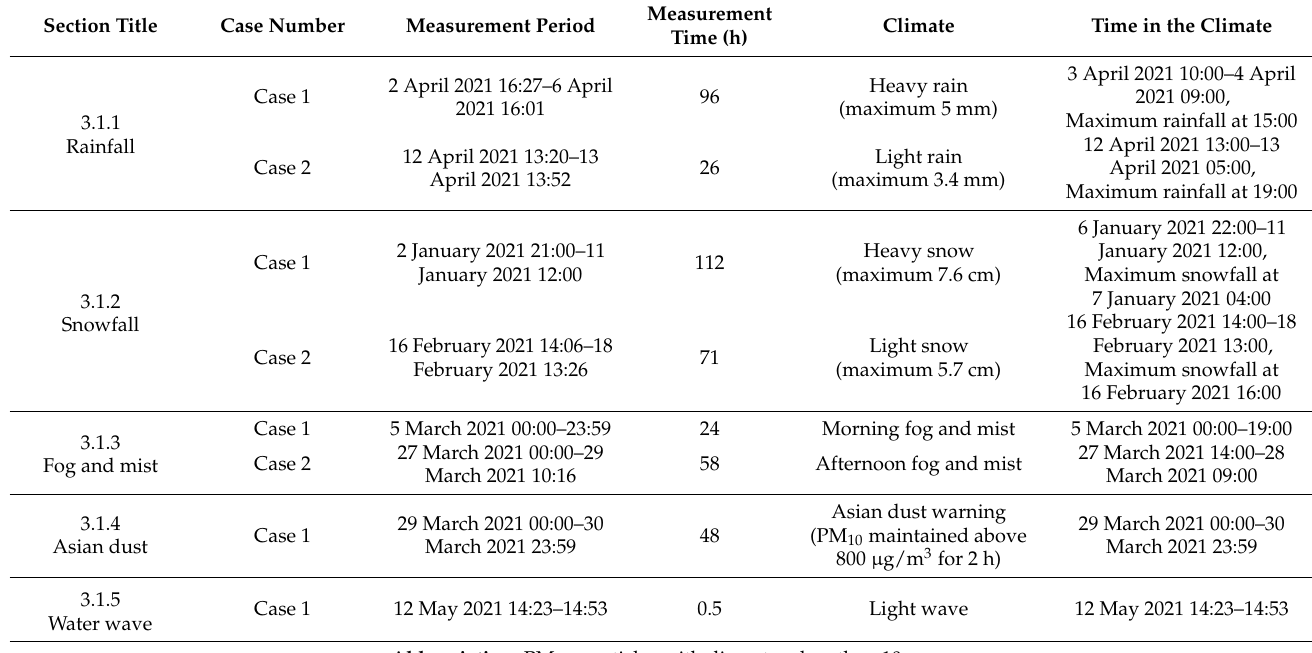
Table 1. Measurement period and climatic conditions in each